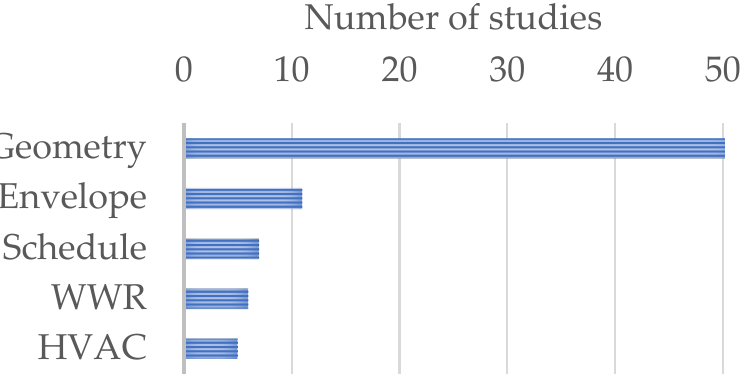
Figure 13. Number of studies using specific measured or surveyed building systems and energy modeling inputs.